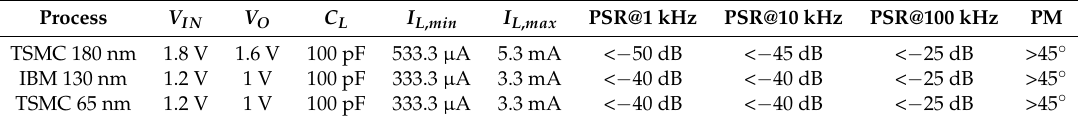
Table 4. Circuit parameters and specification constraints for the optimization of the LDO in two different CMOS processes.